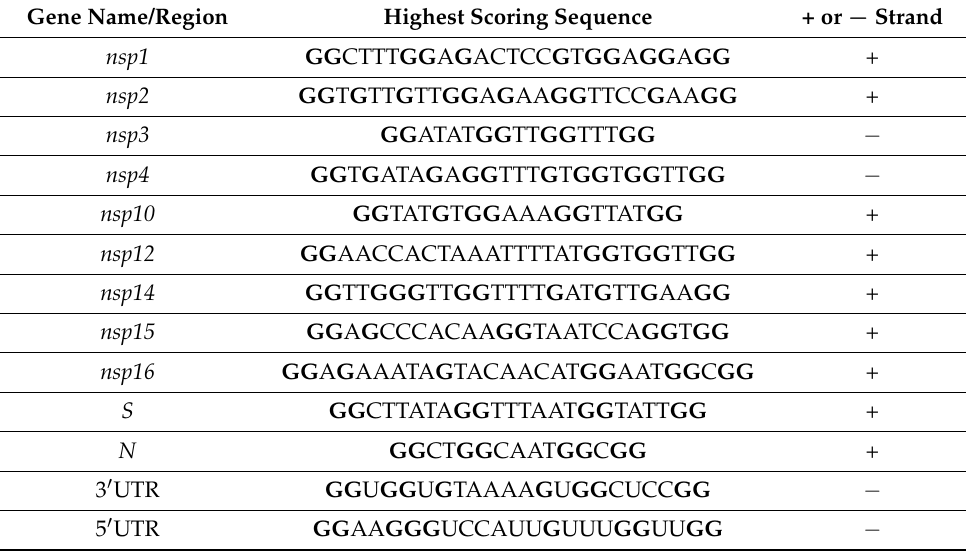
Table 2. SARS-CoV-2 genes containing predicted G-quadruplex (G4)-forming